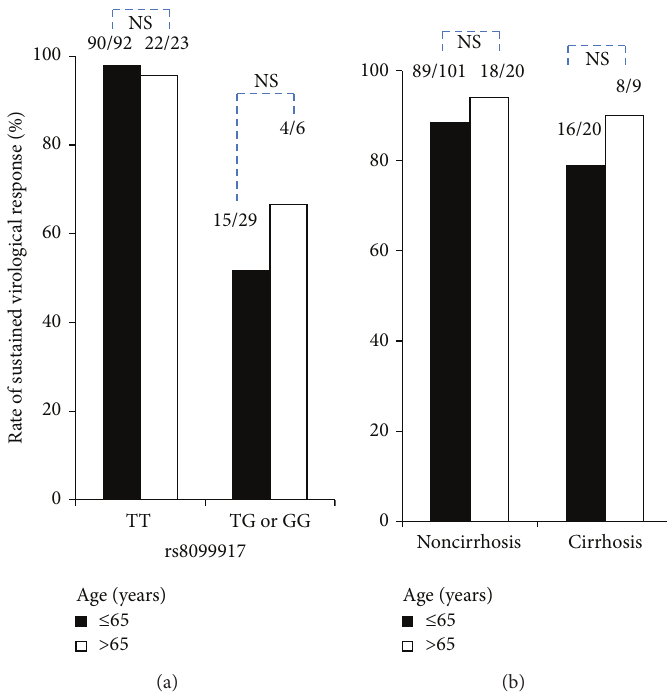
Figure 2: There was no significant relation between sustained virological response rate and age. The patients older than 65 years had hemoglobin levels similar to those aged ≤ 65